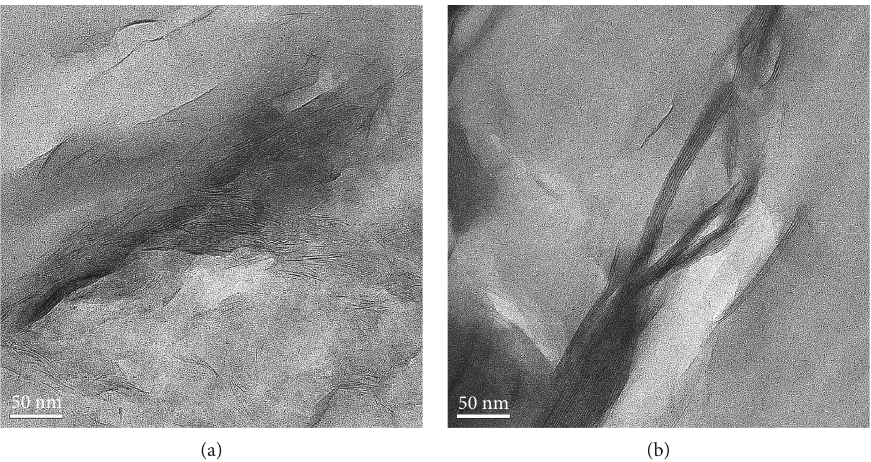
Figure 7: TEM micrographs of PS/clay nanocomposites prepared from the nanoclay aerogel masterbatch and organoclay (at 3wt.% clay